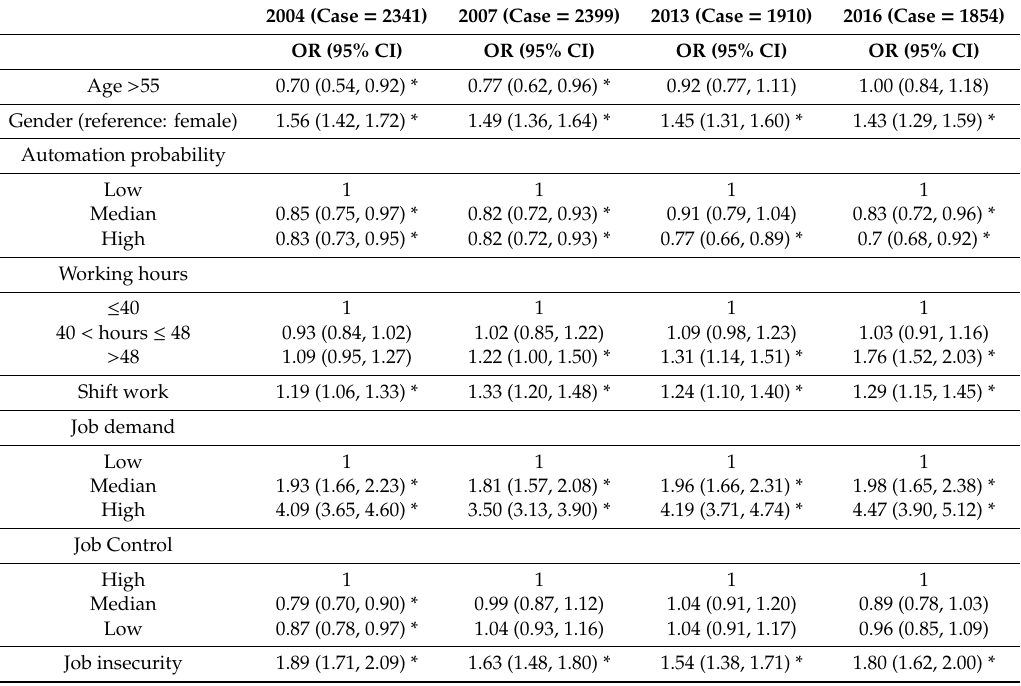
Table 3. Odds ratio and 95% confidence interval (95% CI) for burnout in the survey years, n = 15,288, 17,042, 16,530, and 14,948,